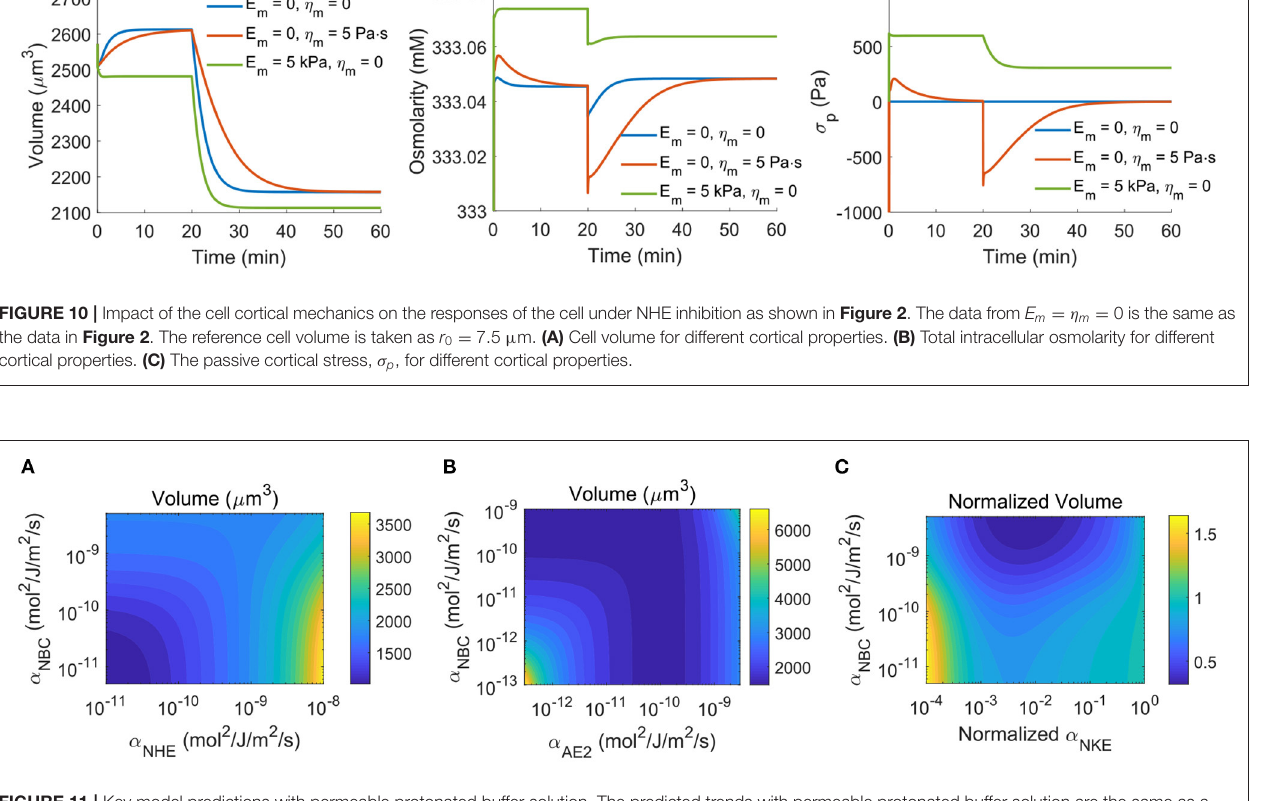
FIGURE 11 | Key model predictions with permeable protonated buffer solution. The predicted trends with permeable protonated buffer solution are the same as a model with non-permeable protonated buffer solution. (A) Contour plot of the cell volume as a function of the permeability coefficient of NBC and NHE. This plot is a counterpart of Figure 4D . (B) Contour plot of the cell volume as a function of the permeability coefficient of NBC and AE2. This plot is a counterpart of Figure 6D . (C) Contour plot of the normalized cell volume as a function of the permeability coefficient of NBC and the normalized permeability coefficient of NKE. This plot is a counterpart of Figure 7G